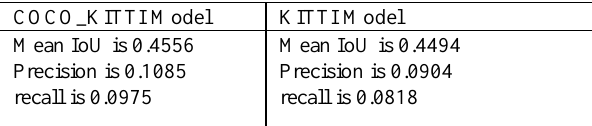
Table 3 The testing results of two